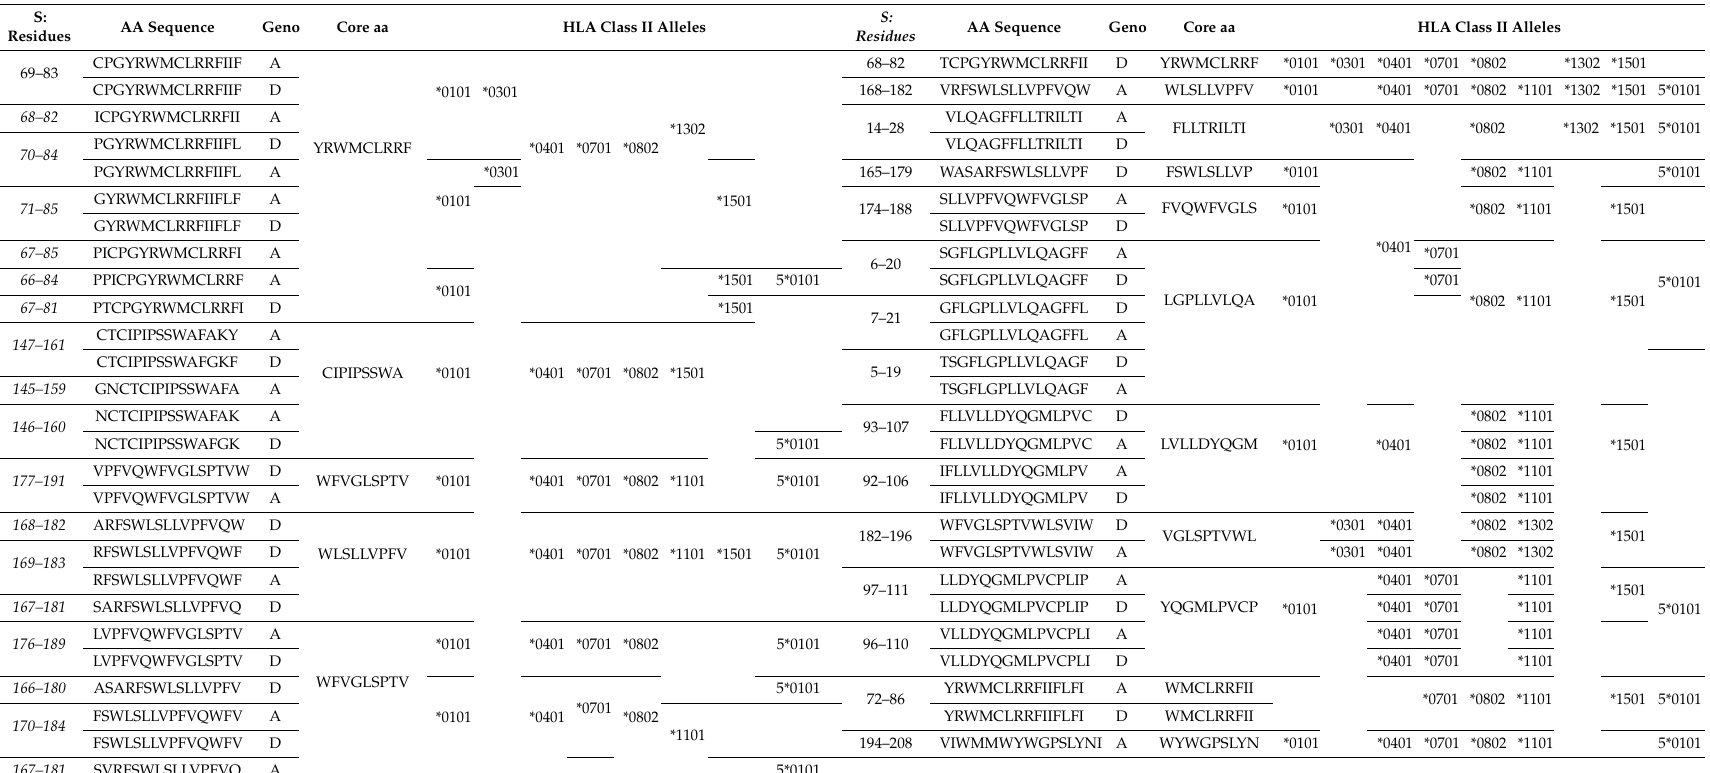
Table 3. List of most promiscuous SB epi mapped from S